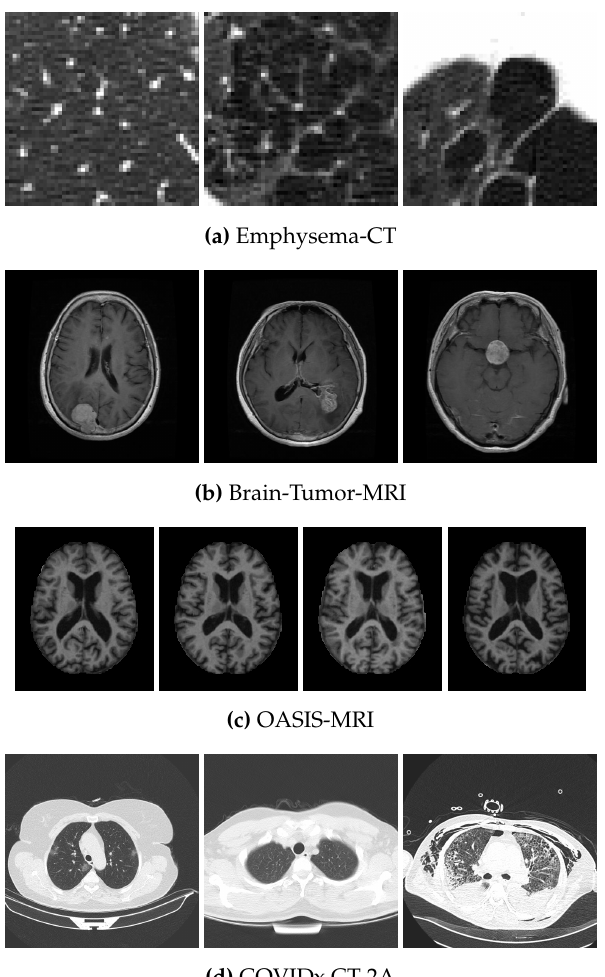
Figure 2. Illustrations of the data sets classes. From left to right, ( a ) shows normal tissue, centrilob- ular emphysema, and paraseptal emphysema; in ( b ): meningioma, glioma, and pituitary tumours. ( c ) represents four classes of dementia: absent, very mild, mild, and moderate. Finally, ( d ) includes COVID, normal, and